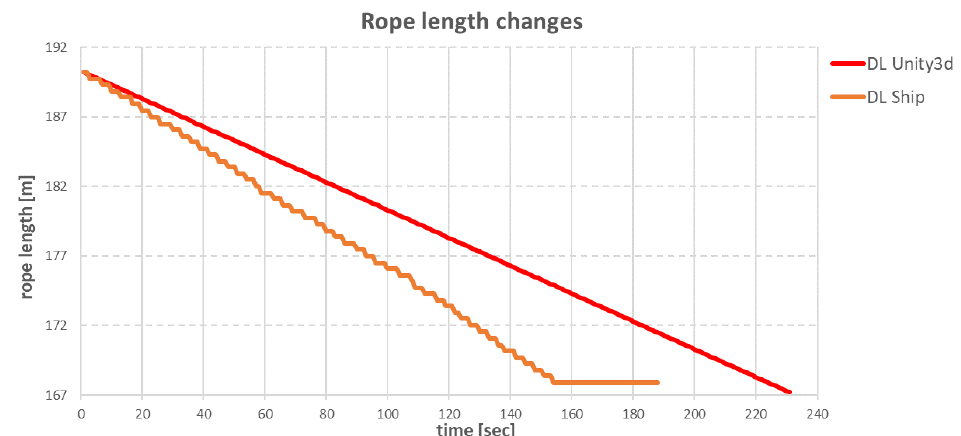
Figure 34. Changes in BP rope lengths over time.